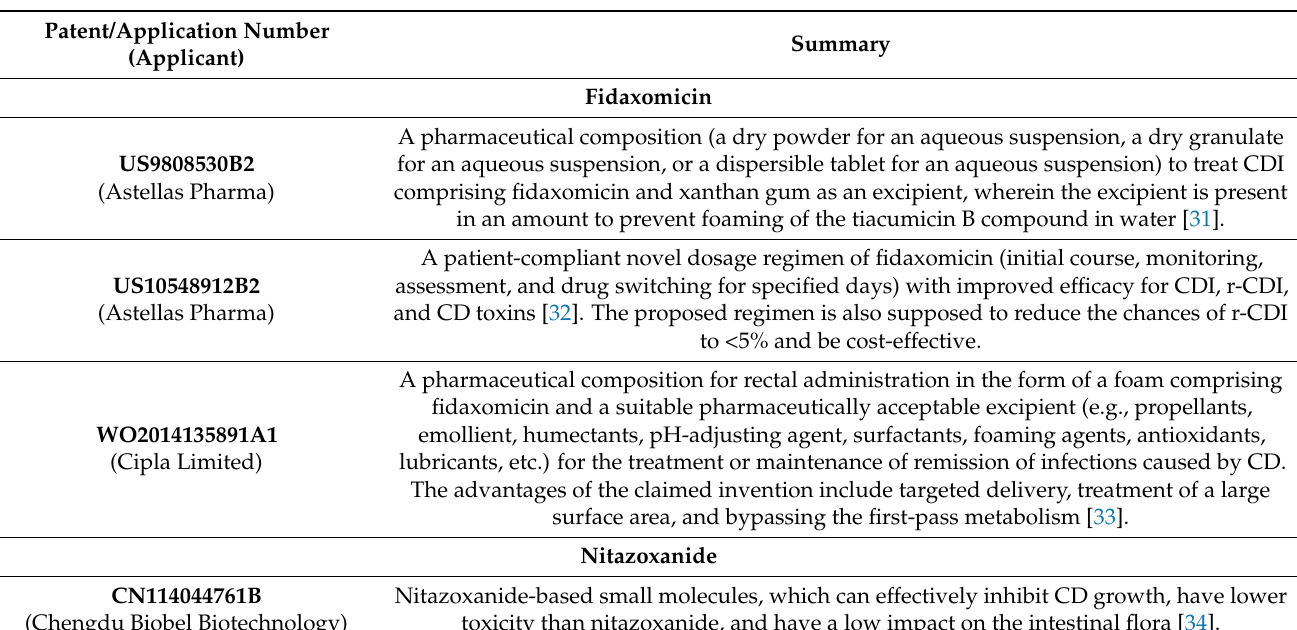
Table 1. Important and relevant inventions using the available treatments for